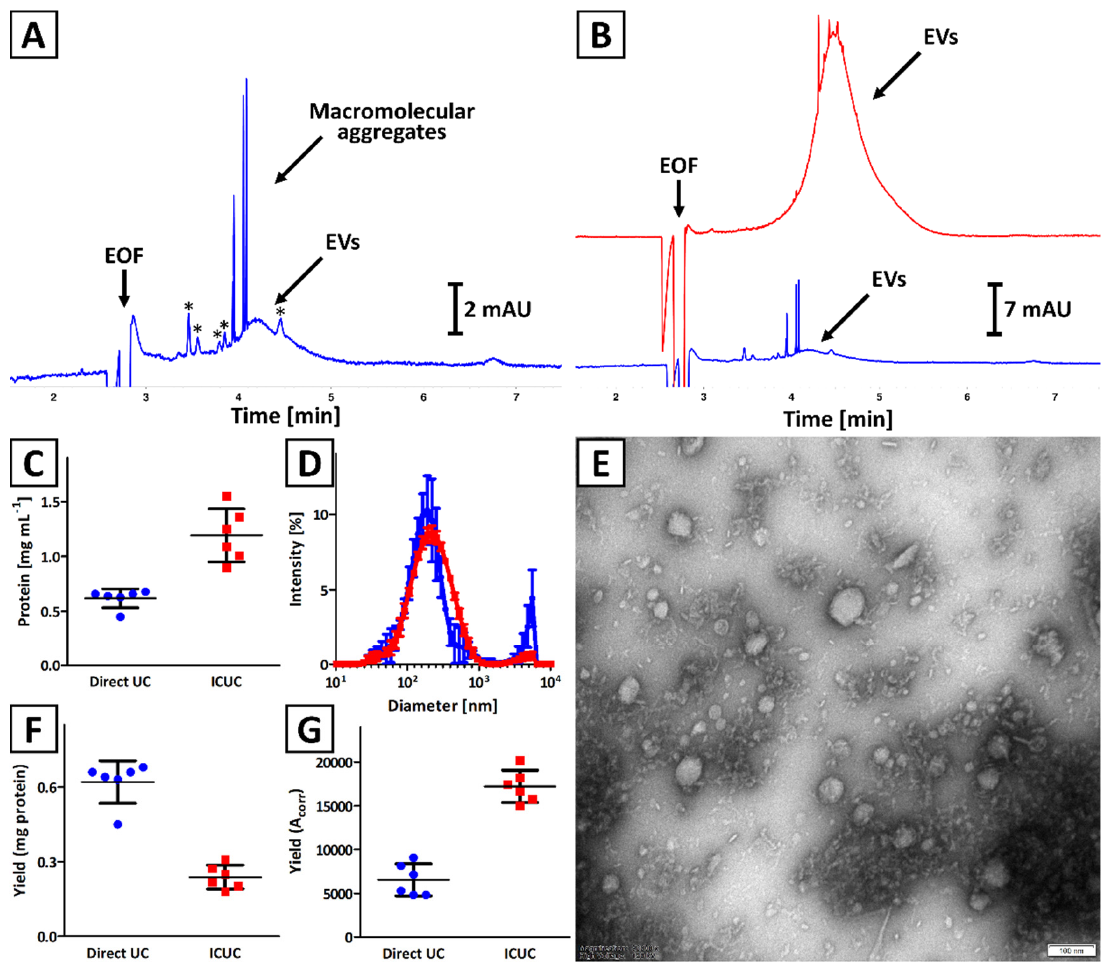
Figure 1. Comparison of isolates obtained with (blue trace) direct UC and (red trace) ICUC methods. ( A , B ) CE analysis of exemplary isolates. Asterisks (*) indicate soluble impurities. ( C ) Total protein concentration was assessed with a BCA test. ( D ) DLS analysis of isolates. Error bars indicate the standard deviation (SD) of measurements performed for 3 independently obtained isolates. ( E ) TEM image of an isolate obtained with ICUC technique. The size bar is equal to 100 nm. ( F ) Isolation yield is expressed as total protein content. ( G ) Isolation yield calculated based on CE analyses results (A corr ) using Equation (2). Bars ( C , F , G ) represent the mean and SD calculated for 6 independently obtained